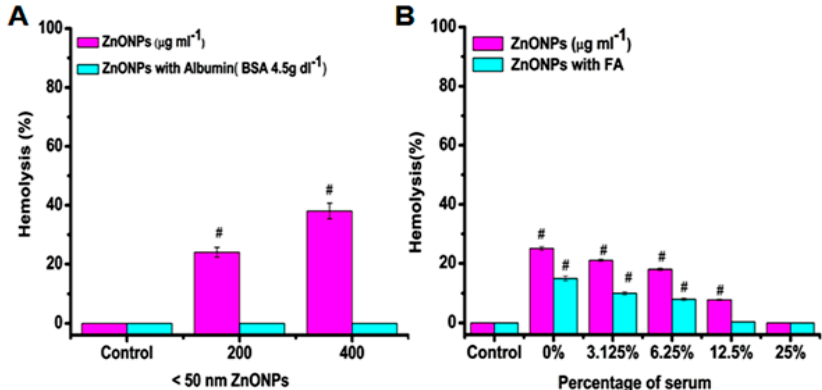
Figure 45. ( A ) Hemolytic effect of ZnO NPs (<50 nm) of two different doses with and without albumin (4.5 µg dl − 1 ) on erythrocytes for 24 h. # denotes significant difference at p ≤ 0.05 of the samples compared to control. ( B ) The effect of ZnO NPs (<50 nm; 200 µg/mL) and ZnO NPs with ferulic acid (FA) exposure on hemolysis in the presence of fetal bovine serum of different concentrations (3.125%, 6.25%, 12.5% and 25%) for 24 h. # denotes significant difference at p ≤ 0.05 of the samples compared to control. Reproduced from [323] under Creative Commons Attribution License.